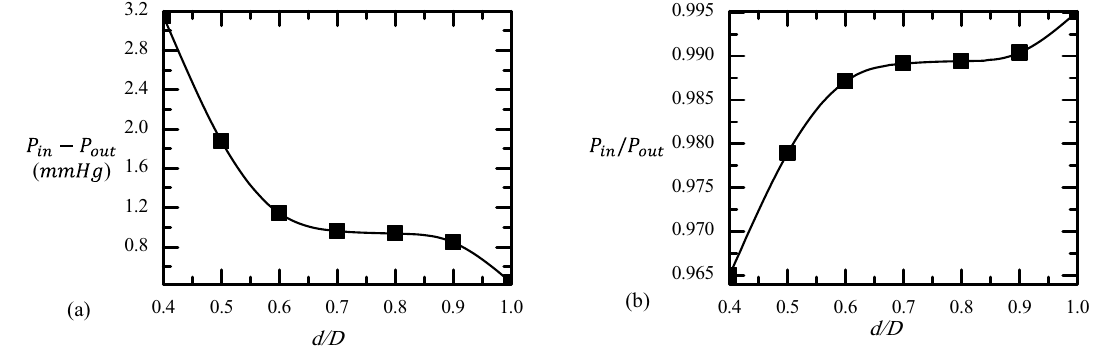
Fig. 4 a Blood flow pressure drop, and b the pressure ratio between the input and output for case 1 at different contraction